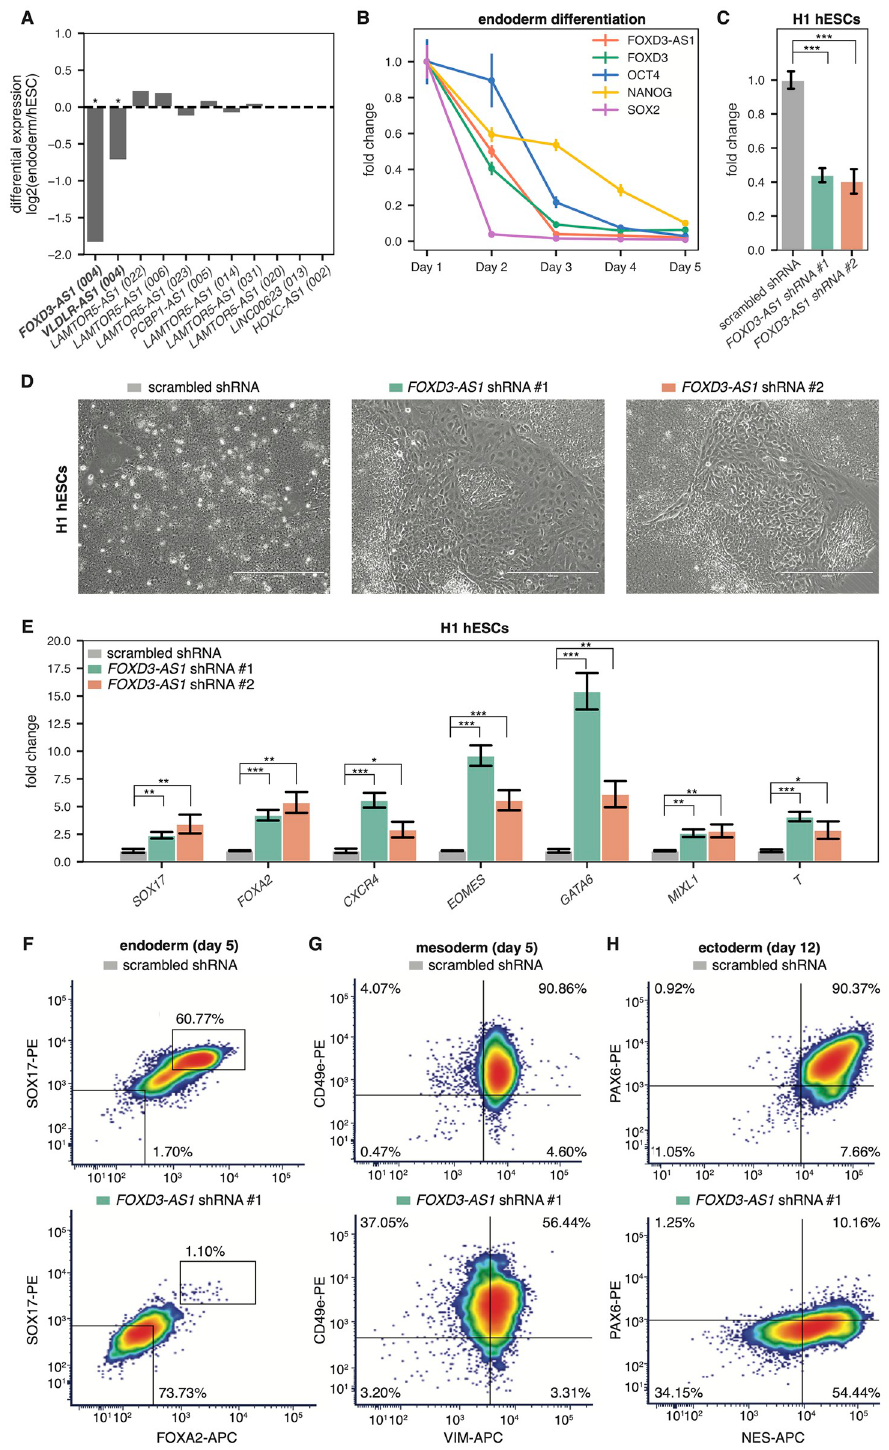
Fig 7. FOXD3-AS1 expression and knockdown in hESCs. (A) Log2 fold change between expression in hESCs and endoderm for all hit lncRNA transcripts in the screen whose loci were predicted to have RNA-based mechanisms of action (Fig 6). � = significant differential expression, sleuth q-value < 0.05. The LAMTOR5-AS1 hit TSS targeted in our screen could not resolve between 6 different LAMTOR5-AS1 transcripts (GENCODE transcript numbers in parantheses), and as such they are all plotted here. (B) RT-qPCR expression time course during definitive endoderm